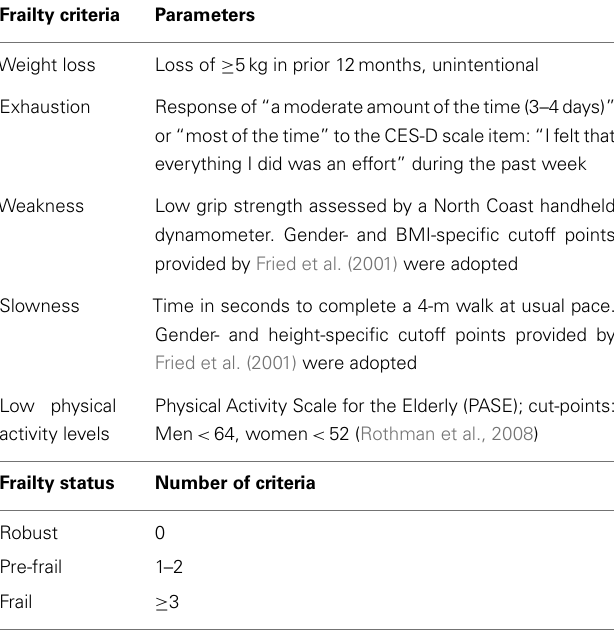
Table 1 | Indicators of physical frailty . Table 2 | Health variables and cut-points used for the computation of a modified Rockwood’s frailty index